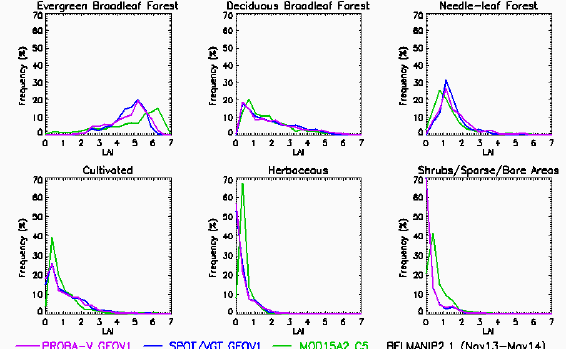
Figure 4: Distribution of LAI values of each product for the BELMANIP2.1 sites during Nov13-May14 period for each biome type.